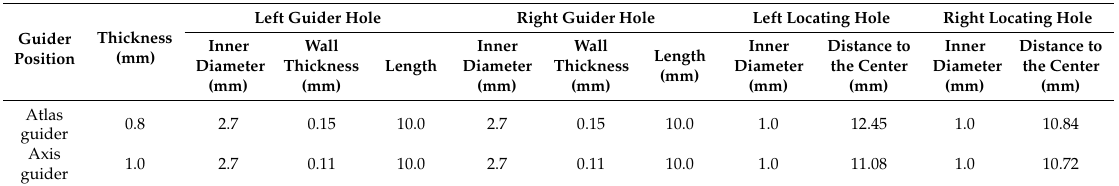
Table 1. Geometric parameters of the spinal surgery